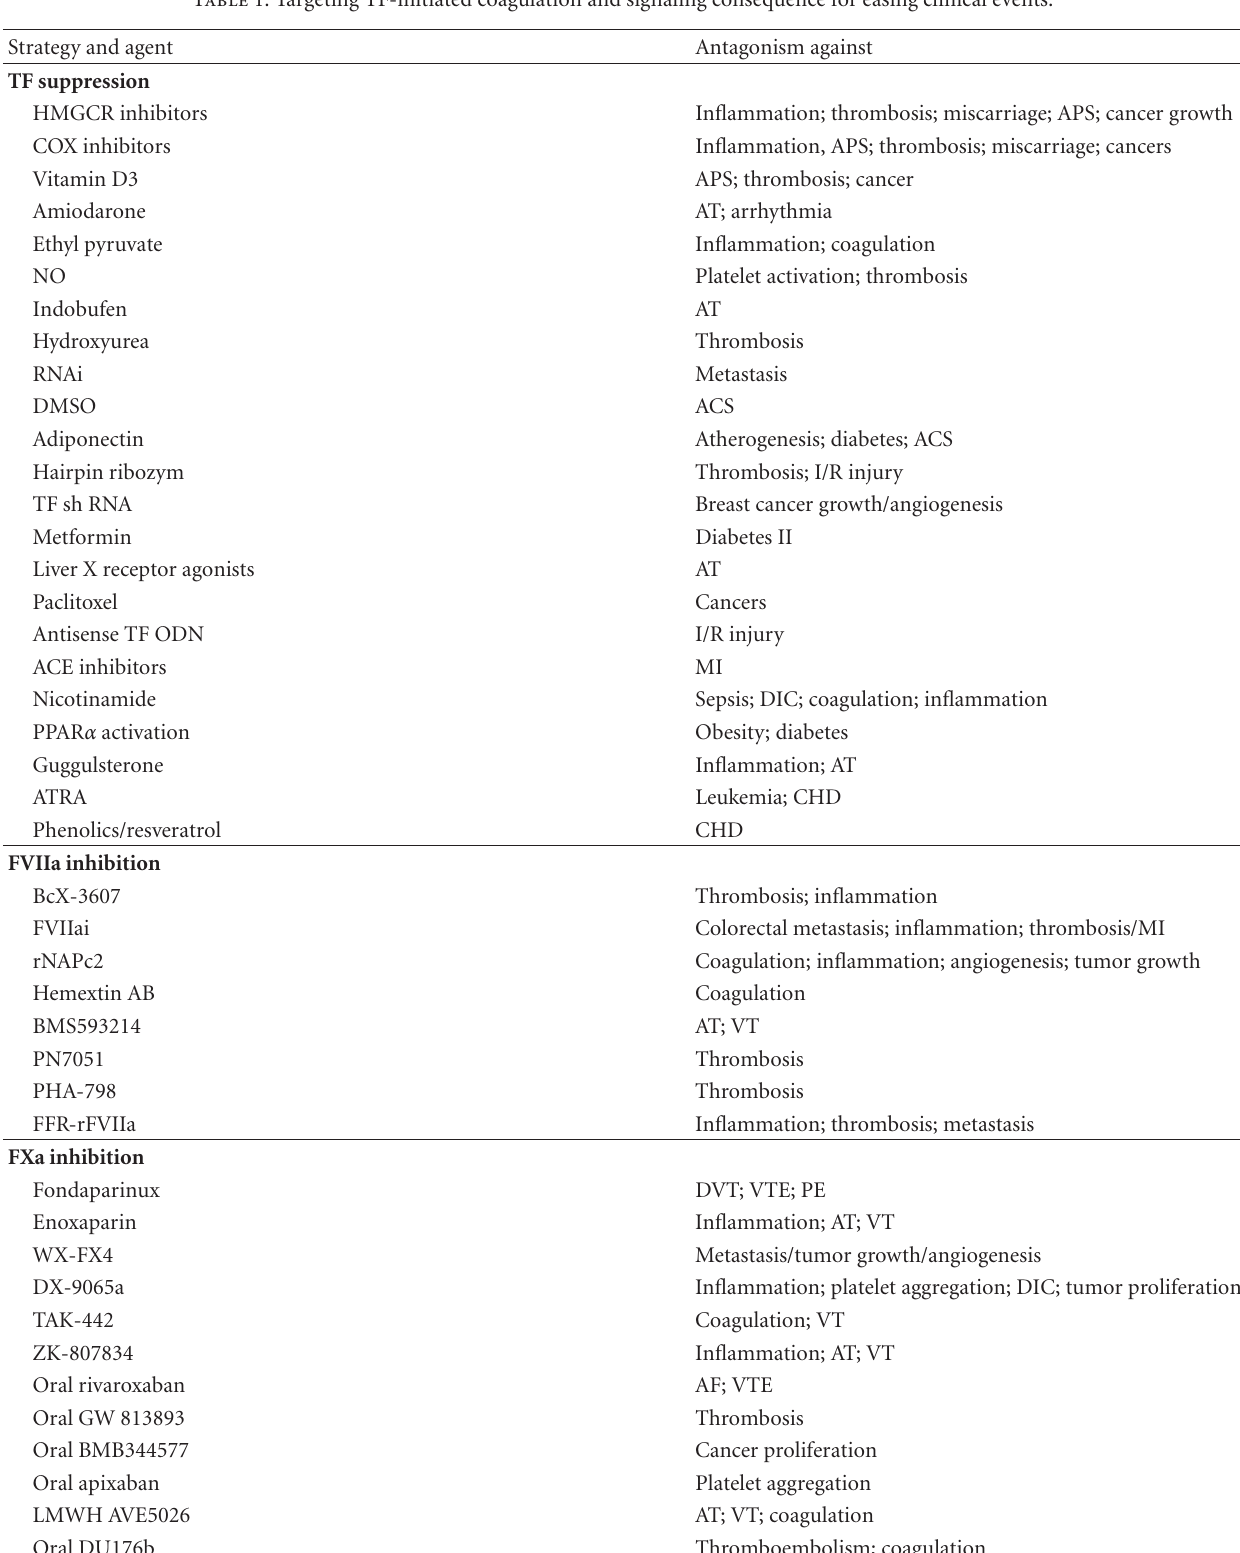
Table 1: Targeting TF-initiated coagulation and signaling consequence for easing clinical